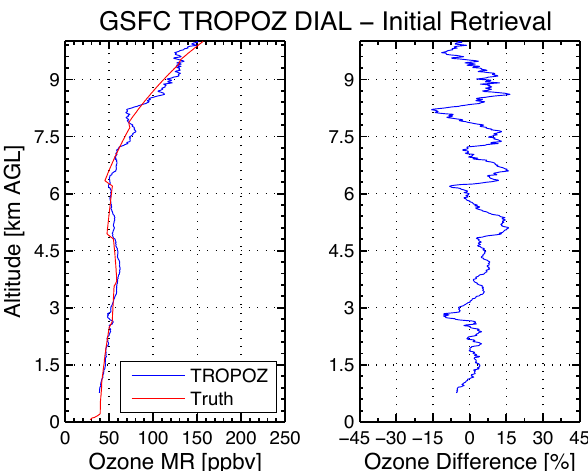
Figure 1. The left panel shows the initial retrieved ozone concentra- tion from the TROPOZ algorithm described in Sullivan et al. (2014) as compared to the known ozone profile used in the simulated lidar return signals. The right panel shows the percent difference from the known profile and retrieved